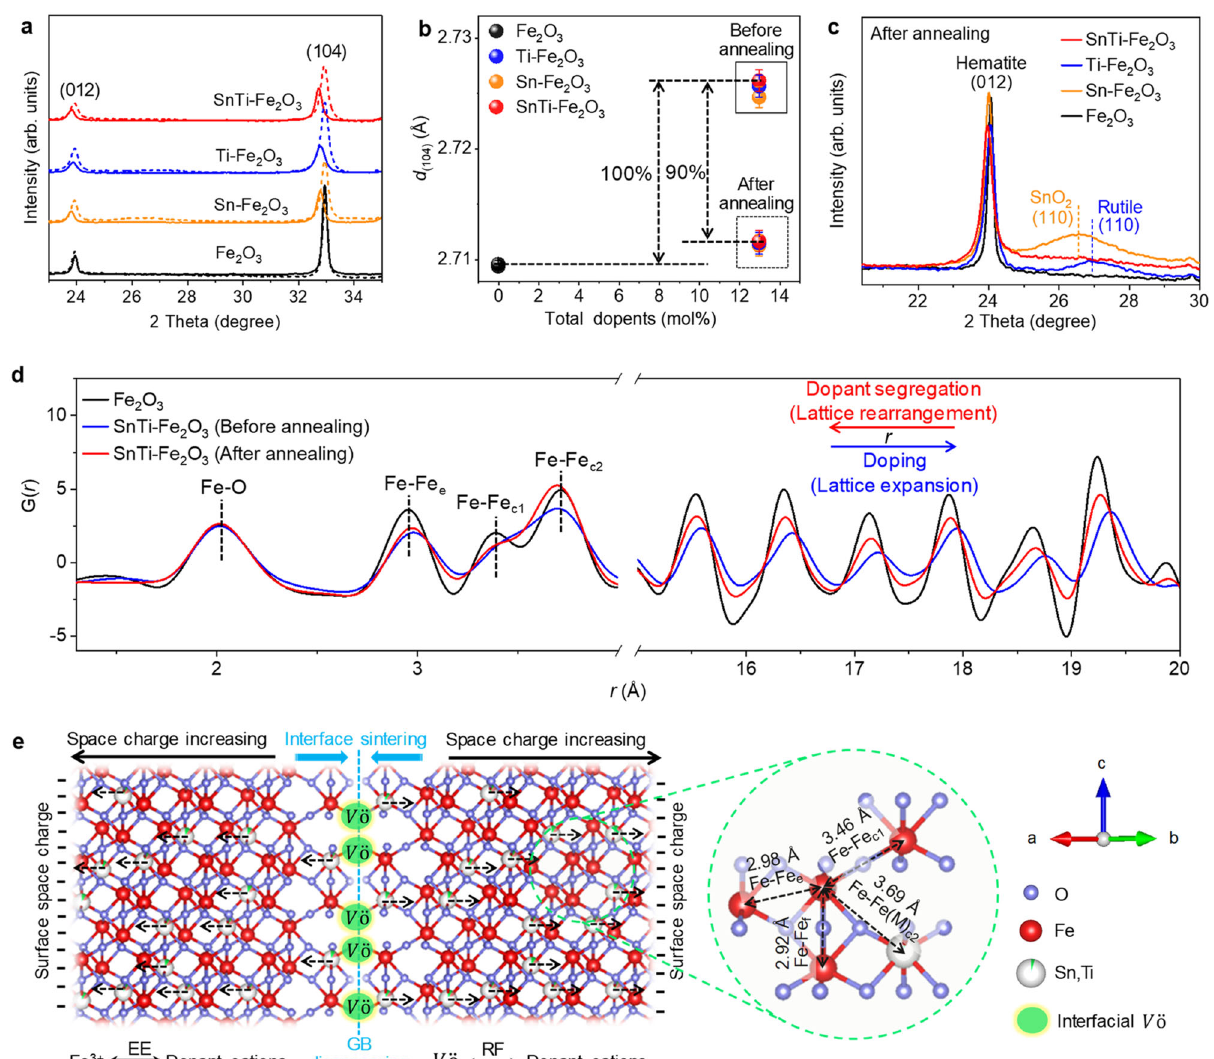
Fig. 3 Crystallographic analyses of dopant segregation. a Powder XRD patterns of the samples measured for as-synthesized (solid lines) and annealed (dashed lines) samples with a scanning rate of 10° min − 1 . b Lattice spacing d 104 values of the samples before and after annealing. c Powder XRD patterns of annealed samples measured with a scanning rate of 1.0° min − 1 . d PDF analyses of the samples. The peak at approximately 2 Å is composed of shorter Fe – O (1.94 Å) and longer Fe – O (2.12 Å) distances. The peak at approximately 3 Å is composed of the fi rst neighbor edge-sharing (Fe – Fe e , 2.95 Å) and face- sharing (Fe – Fe f , 2.90 Å) Fe – Fe distances. The fi rst and second neighbor corner-sharing Fe – Fe pairs are at 3.39 Å (Fe – Fe c1 ) and 3.72 Å (Fe – Fe c2 ), respectively 62 . e Schematic illustration of the driving force for oriented dopant segregation in hematite during thermal treatment. The self-segregation is driven by the space charges induced by the dopants and V O , RF between the dopant cations and positively charged V O , and EE induced by the size mismatch between the dopant and the host